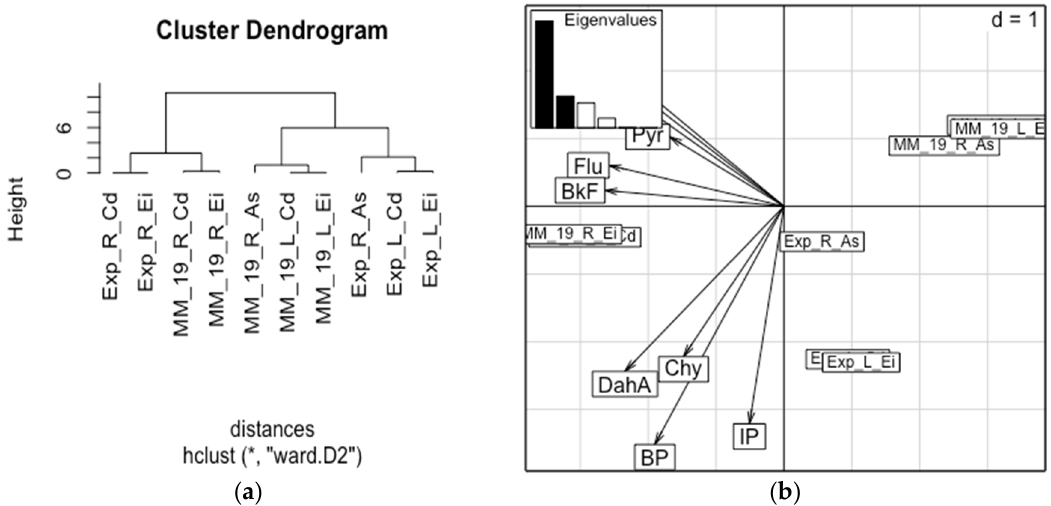
Figure 4. Comparison between model and experimentation. ( a ) is the cluster dendrogram of the two models with respect to plant compartments; ( b ) shows the correlation between PAHs and compartments of each plant species for both models.